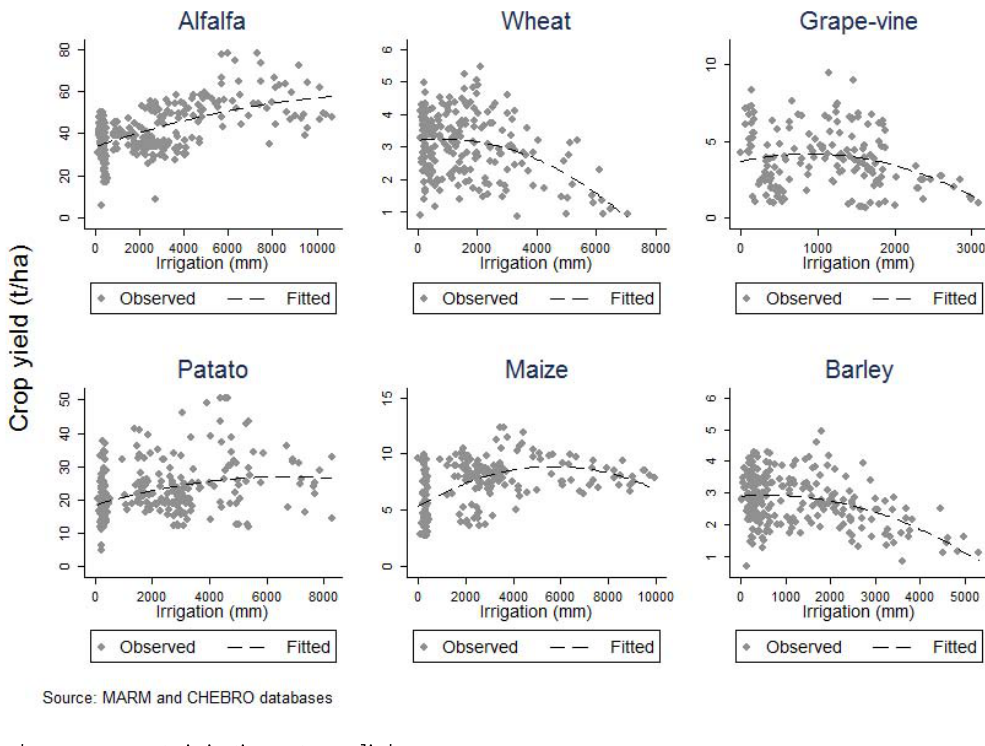
Fig. 3. Observed crop response to irrigation water applied. Table 4. Irrigated area by irrigation systems. Irrigation Area and Porcentages Region Large systems Small systems Total ha %